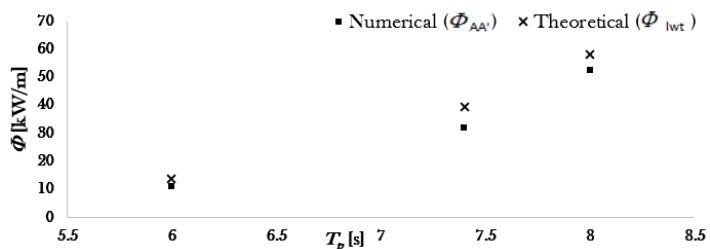
Figure 7. The mean energy flux of the incident waves. Crosses show theoretical values, calculated by Equation (32), and squares the numerical ones computed in section AA (cid:48) , by means of Equation (31).